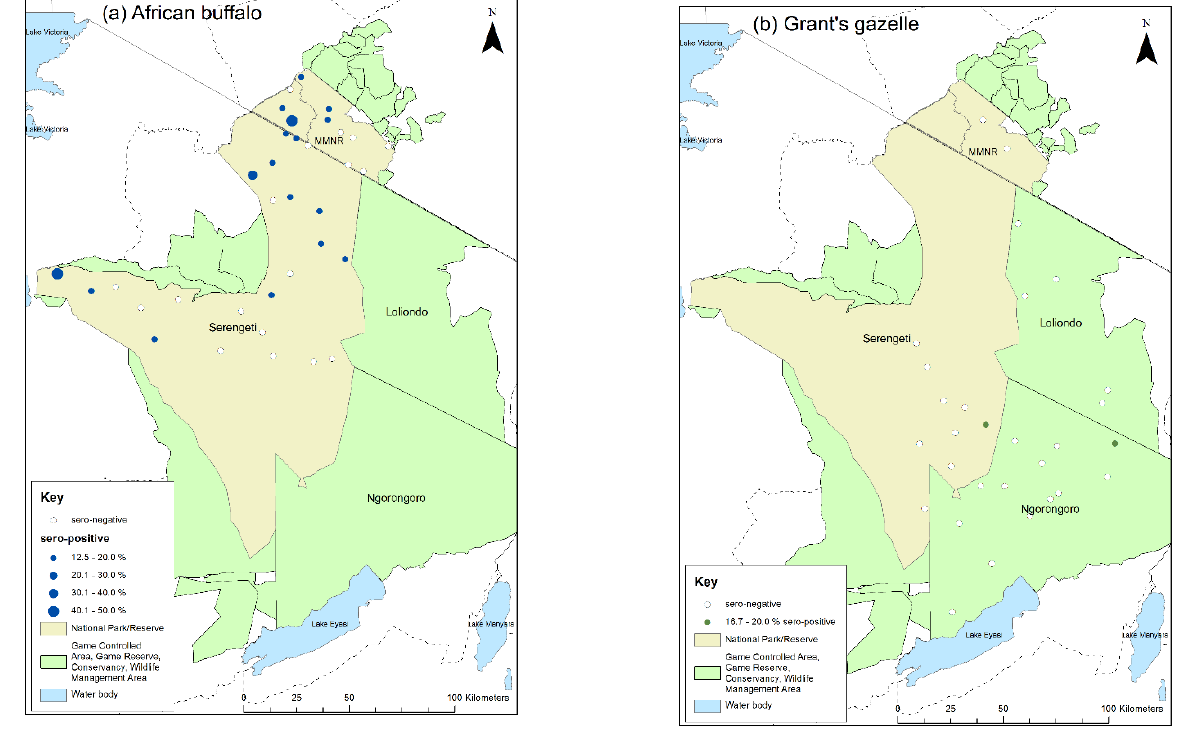
Figure 8. Map of sampling sites for the cross-sectional survey 2018–2019 indicating the proportion of cELISA positive animals at each site: ( a ) African buffalo; ( b ) Grant’s gazelle. Positive animals are those with percentage inhibition <50 (interpretation 1).